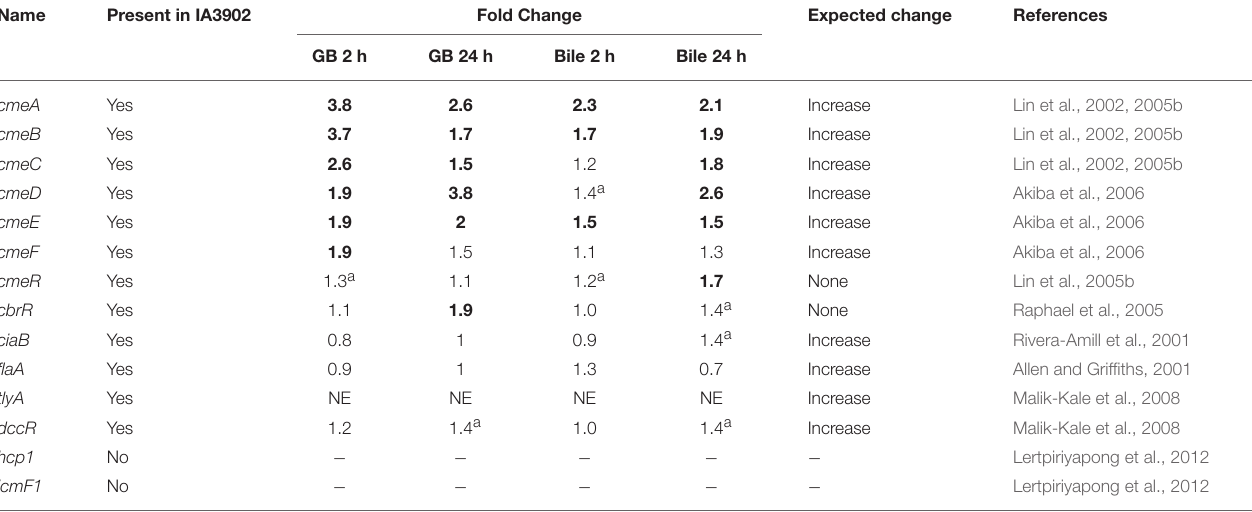
TABLE 7 | Fold change expression data for the 14 genes previously reported to be involved in the bile tolerance response in Campylobacter , 2 of which are not present in strain